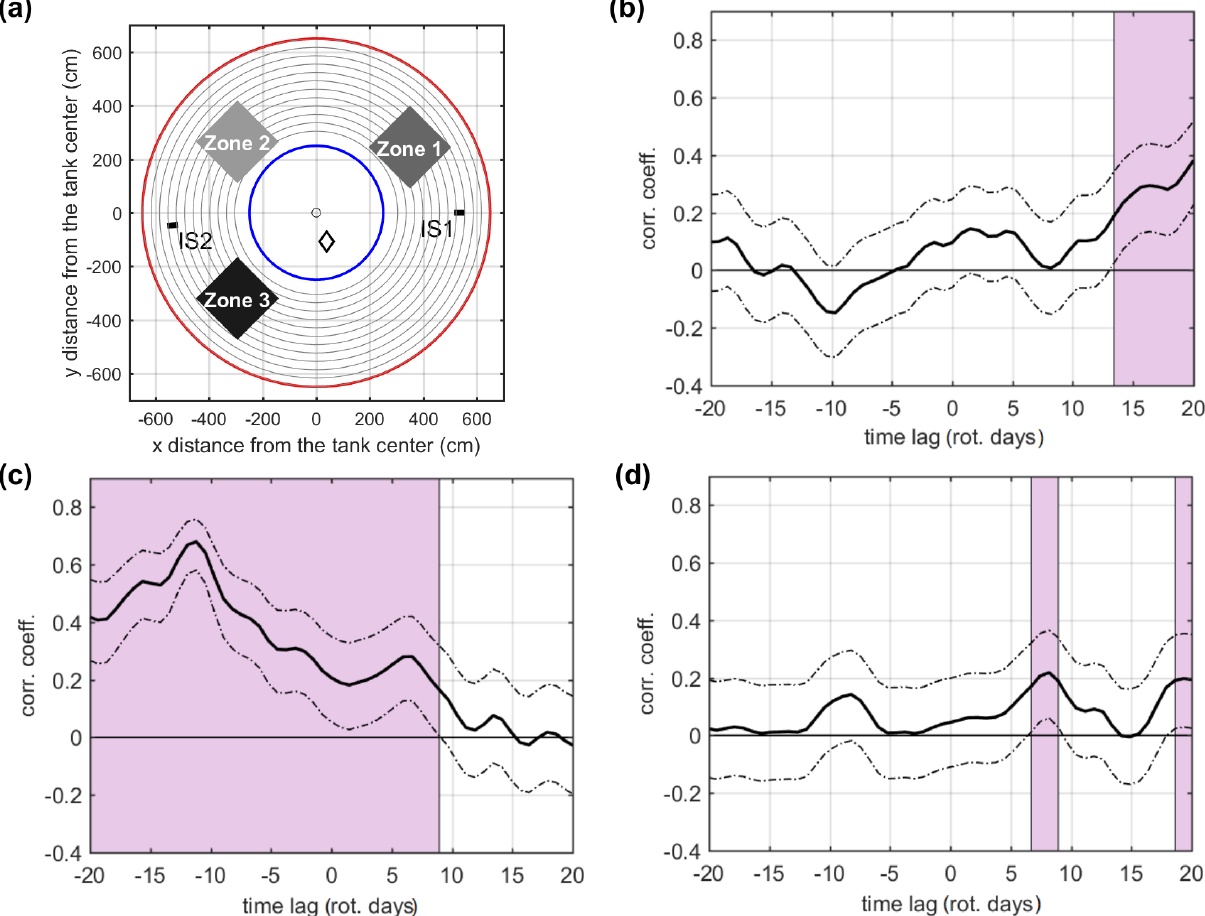
Figure 10. Vorticity correlations over the slope for EXP24. Position of the three selected zones (a) . Time-lagged correlation coefficients (corr. coeff.; solid line) between zones 1 and 2 (b) , between zones 1 and 3 (c) , and between zones 2 and 3 (d) . Upper and lower limits of the coefficients, corresponding to the 95% confidence level, are indicated by dot-dash lines. Rose-shaded areas indicate a positive correlation at the 95% confidence limits. The limits for the maximum time lag were set by the calculated correlation time for the entire slope area, equal to approximately 22 rotation (rot.) days.